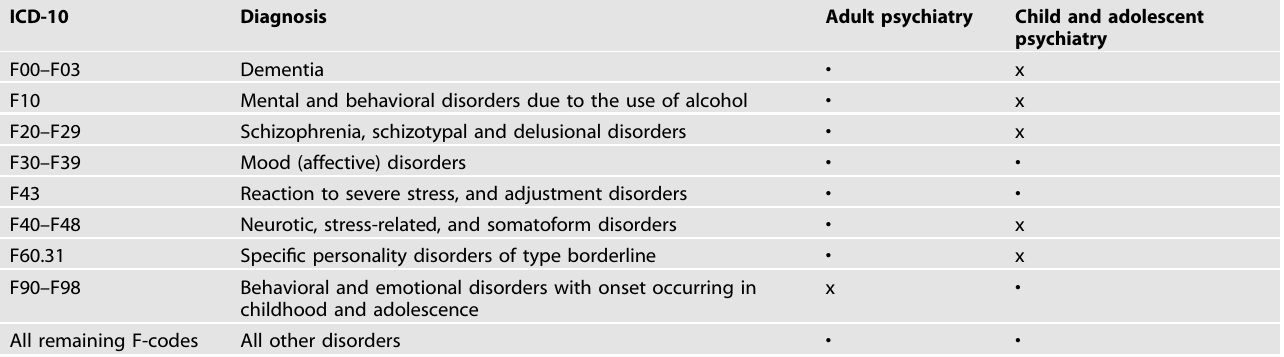
Table 1. A priori de fi ned diagnostic